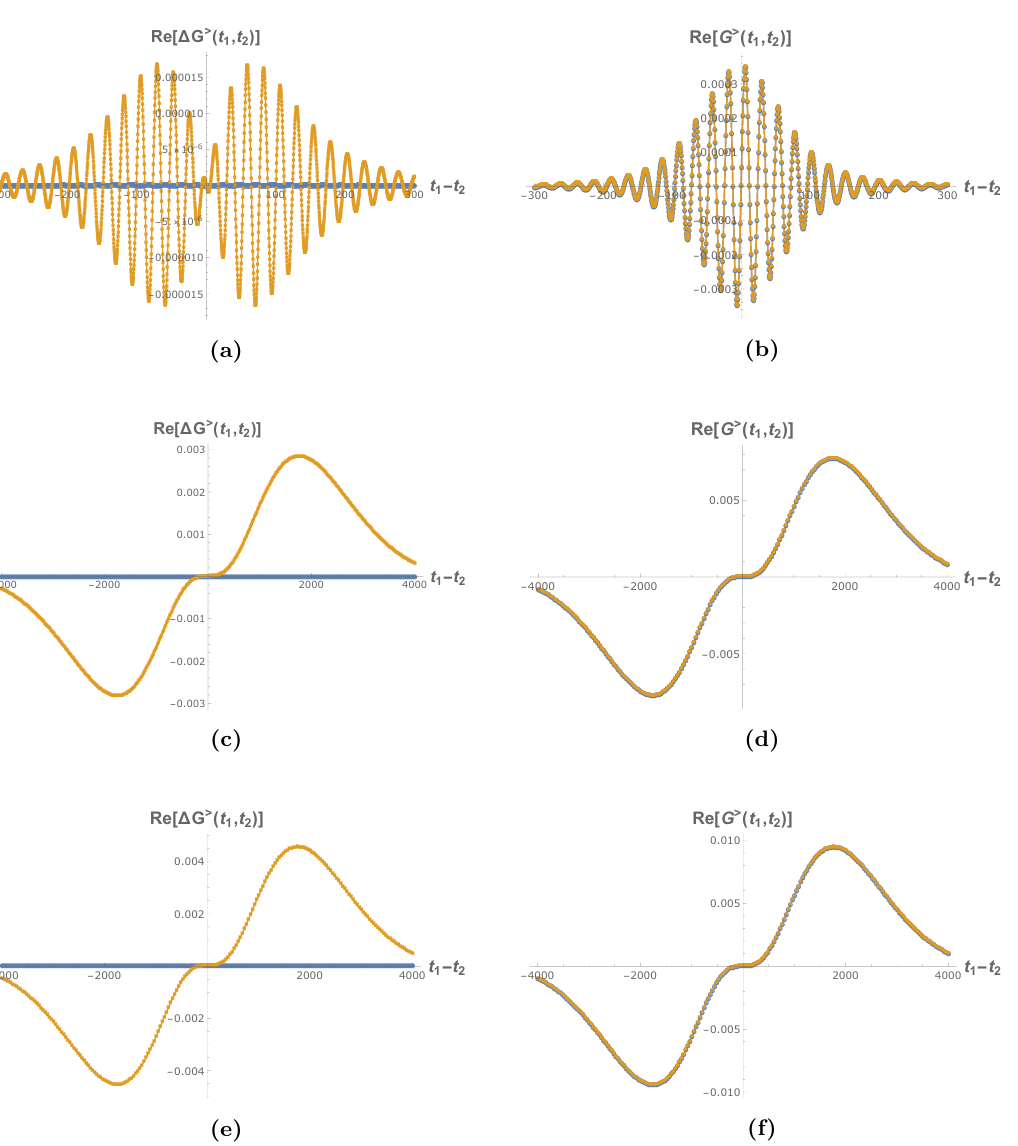
Figure 8. Plots on the left hand side: blue curves are difference of the real part of the greater Green’s functions of the final state and the thermal state with matching energy. Orange plots are difference of the real part of the greater Green’s functions of the final state and the initial state. Plots on the right hand side: blue curves are real part of the greater Green’s functions of the final state. Orange plots are the real part of the greater Green’s functions of the thermal state with matching energy. (a) and (b) are plots for case 1 starting from the dilute gas state with µ = − 0 . 27 , η = 0 and β = 30 and quantum quench using time dependent J 2 term. (c) and (d) are plots for case 2 starting from the dilute gas state with µ = 0 , η = 0 . 27 and β = 30 and quantum quench using time dependent J 2 term. And (e) and (f) are plots for case 3 starting from the dilute gas state with µ = 0 , η = 0 . 27 and β = 30 and quantum quench using time dependent J 6